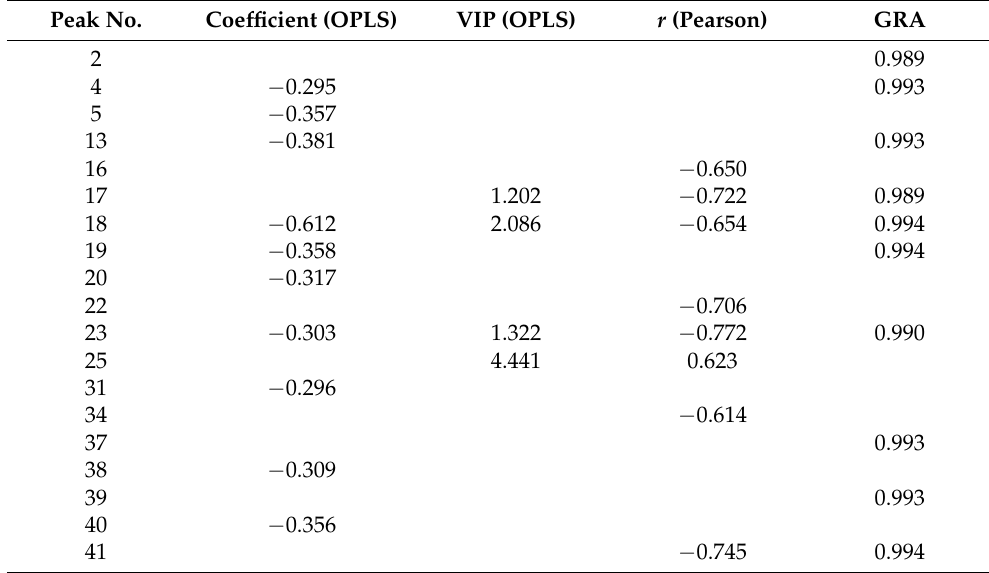
Table 2. Summary of feature extraction and spectrum-effect correlation